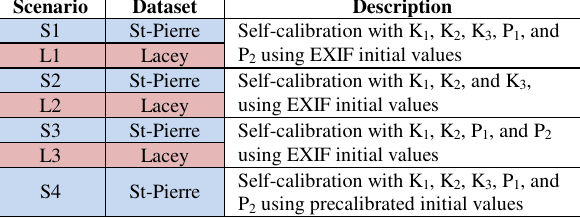
Table 1. Four self-calibration scenarios were tested. In three cases, the EXIF value for the focal length was used as initial value. The EXIF cases were used on both data sets. A fourth scenario with precalibrated initial values was used for the St- Pierre data